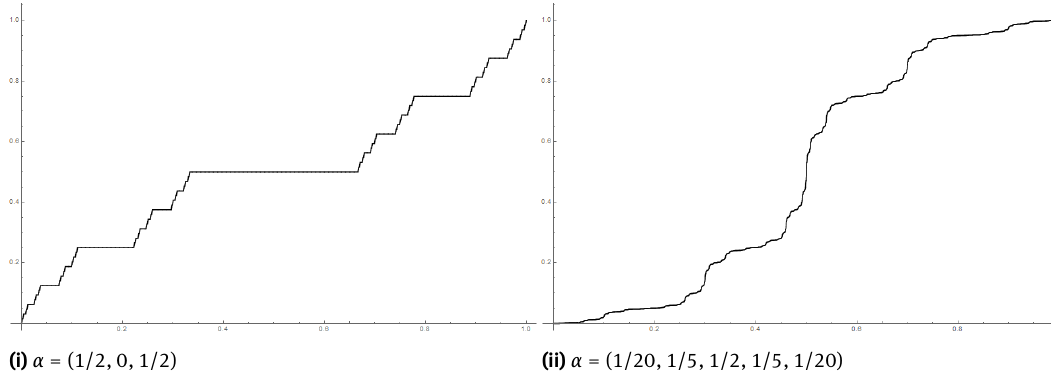
Figure 1: Graph of F µ α for selected α